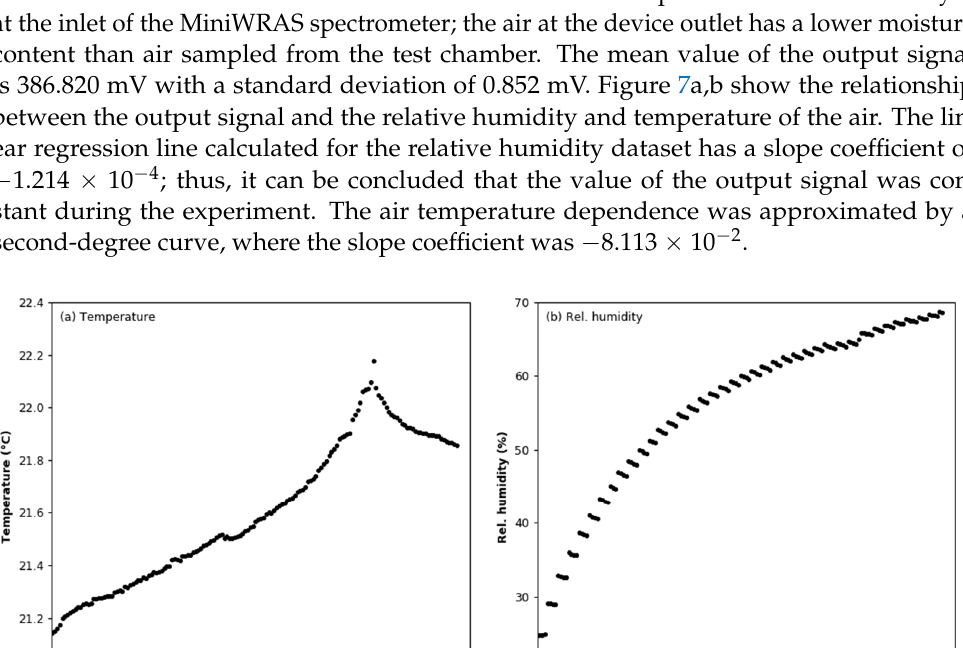
Figure 5. Variations in the output signal during the stability test: 1- min averages.